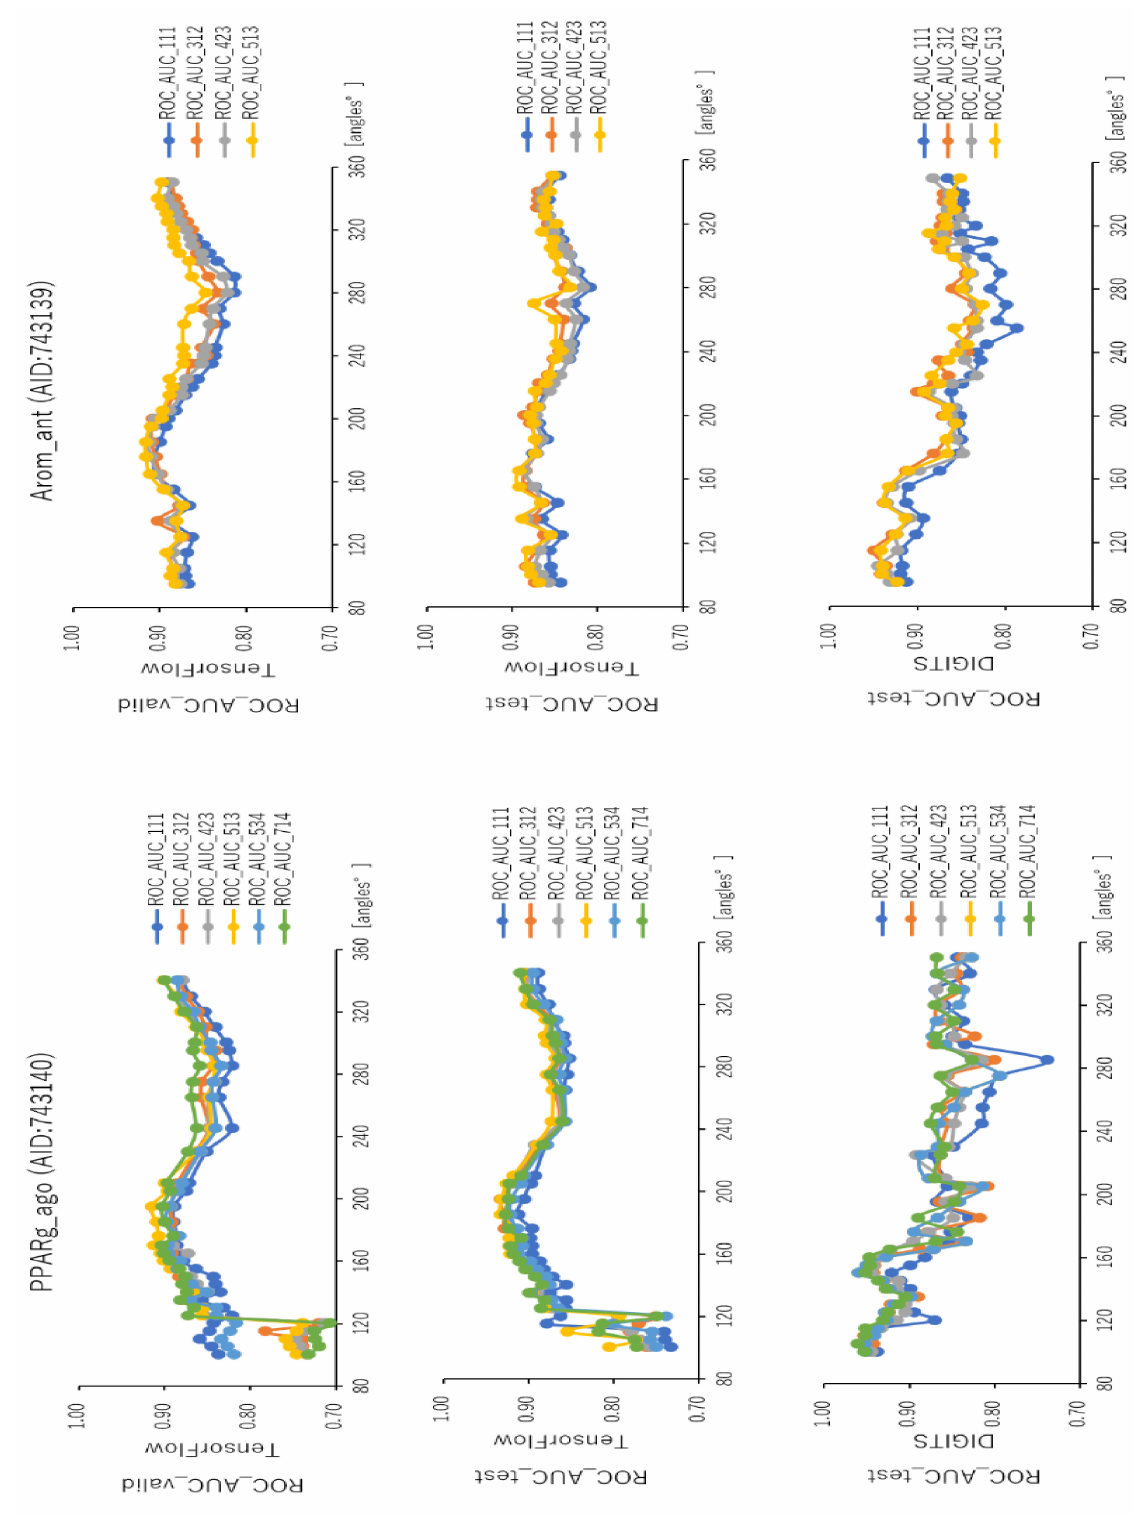
Figure 3. ROC_AUC for PPARg_ago (AID:743140) and Arom_ant (AID:743139) on the validation and test datasets using TensorFlow and Keras in the test dataset using DIGITS with 31 angles in DeepSnap-DL. The different curves represent different ratios of splits among the dataset, training:validation:test =1:1:1, 3:1:2, 4:2:3, 5:1:3, 5:3:4, and 7:1:4, respectively. Three-fold experiments were